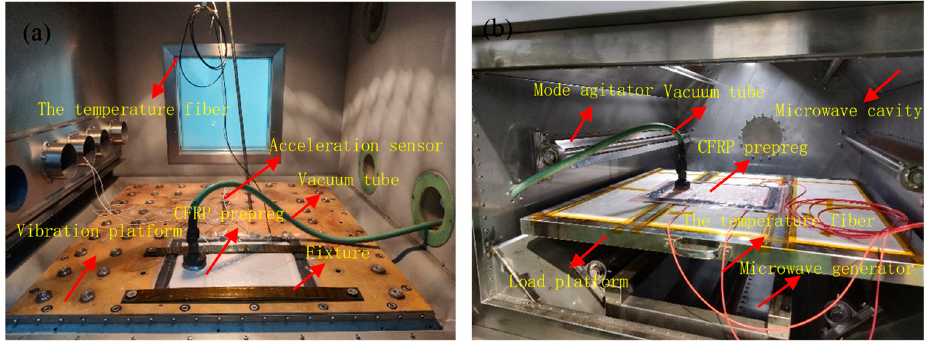
Figure 1. Experimental platform for vibration and microwave curing of composite, ( a ) laminate in vibration processing platform, ( b ) laminate in microwave heating chamber.